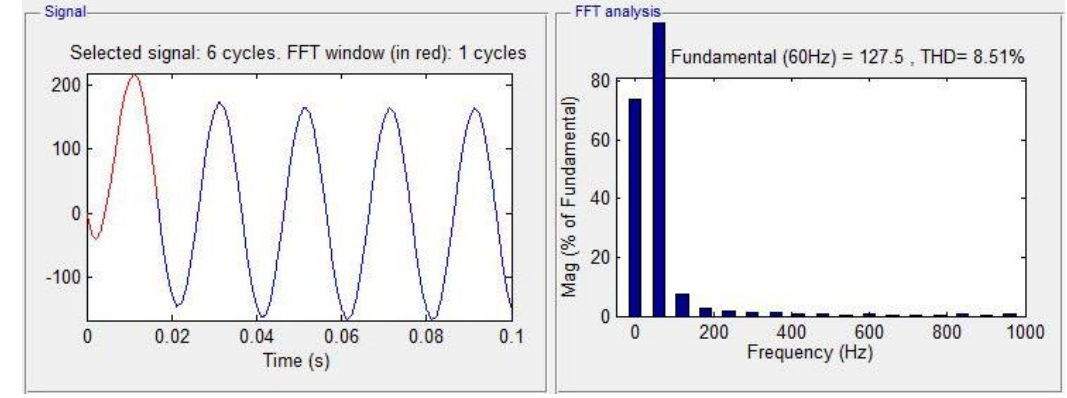
Figure 8. The total harmonic distortion (THD) of the load’s current.